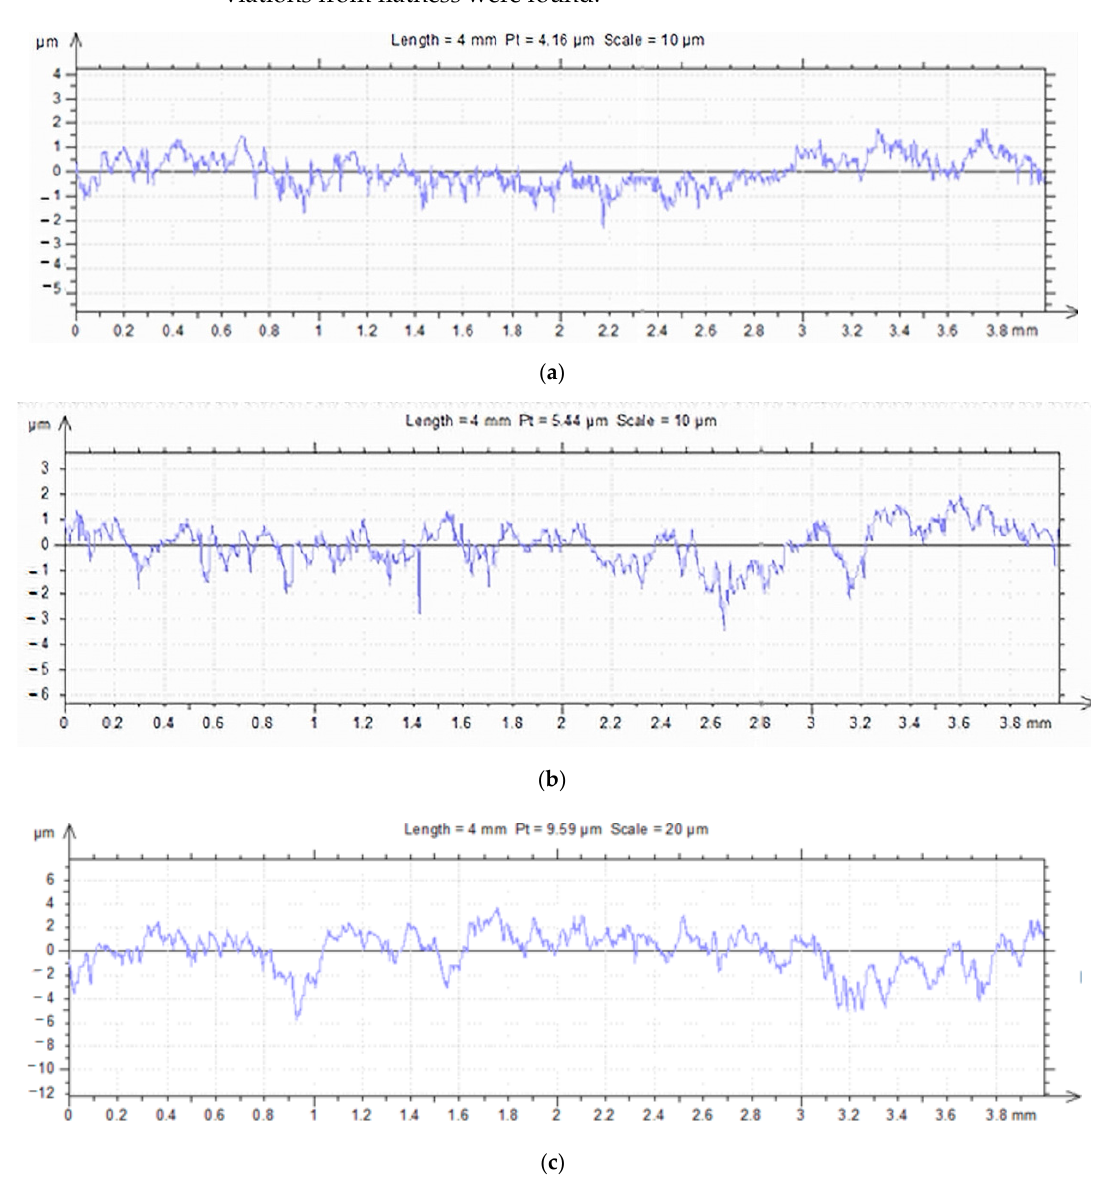
Figure 5. The profile curves for the sample contact surfaces: ( a ) 1/1.2, ( b ) 2/2.1, and ( c ) 3/3.1 .